Question: In one sentence, what is this figure communicating?
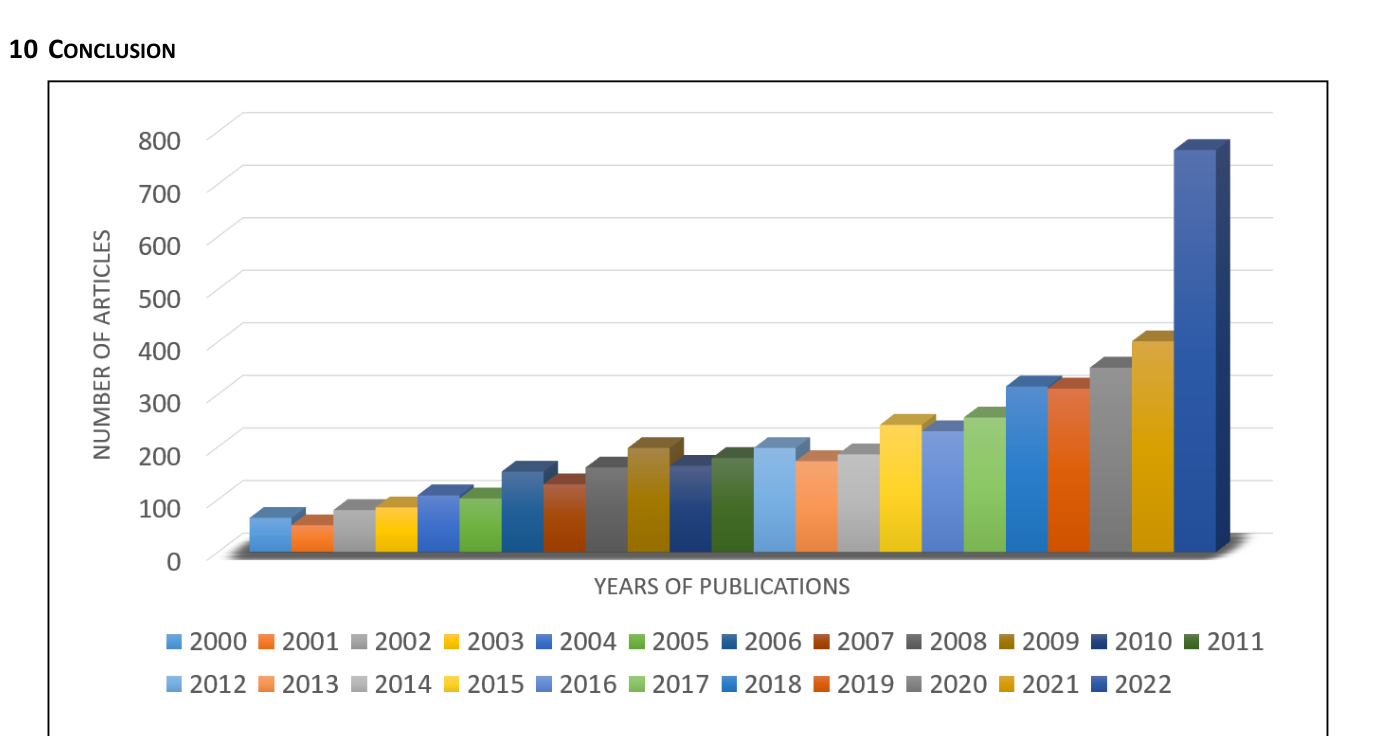
Answer: Number of Articles per year.